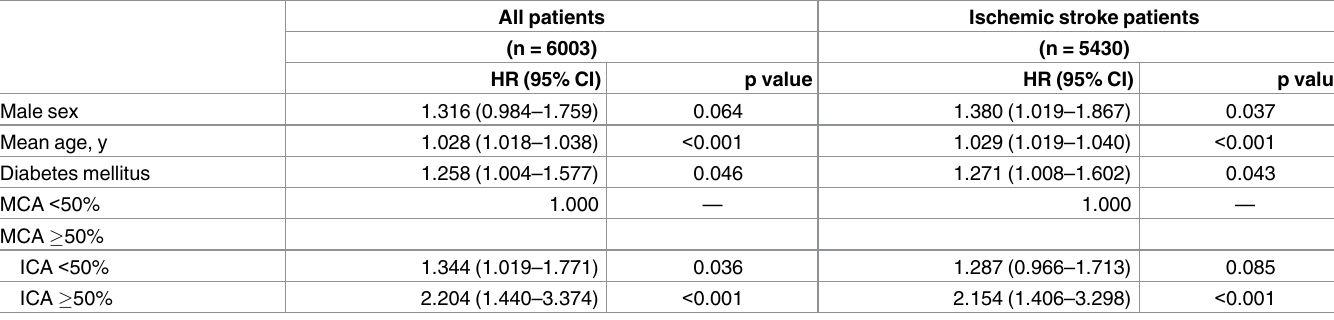
Table 4. Cox-model for stroke recurrenceor death at 3 months after stroke. All patients Ischemic stroke